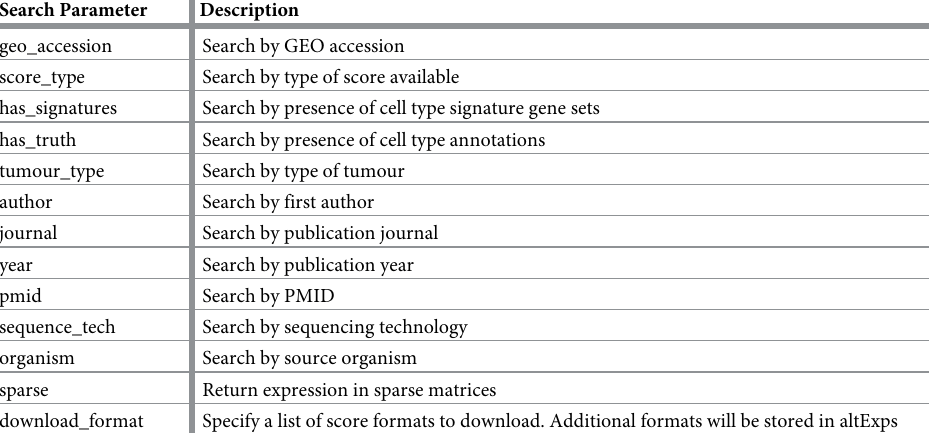
Table 1. A list of search parameters that can be passed to queryTME in order to filter the available